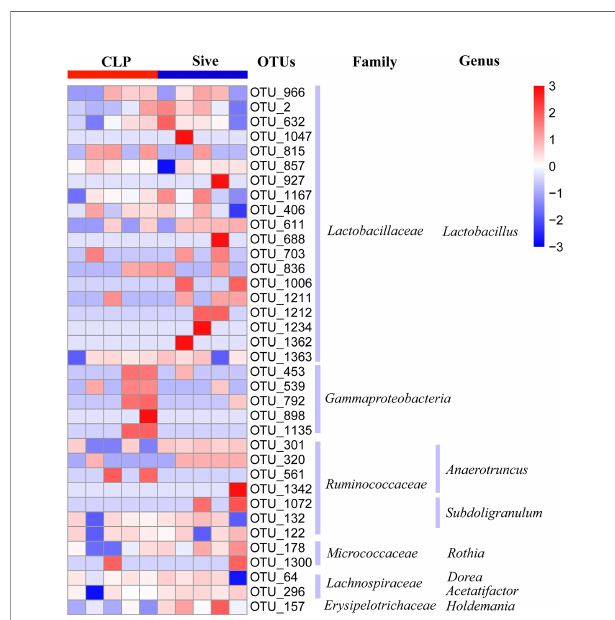
FIGURE 3 | Relative abundance heatmap of 36 differential OTUs between the CLP and Sive groups. Data were z-transformed and analyzed using the Mann-Whitney U test. All 36 OTUs were classi fi ed into families and genera.